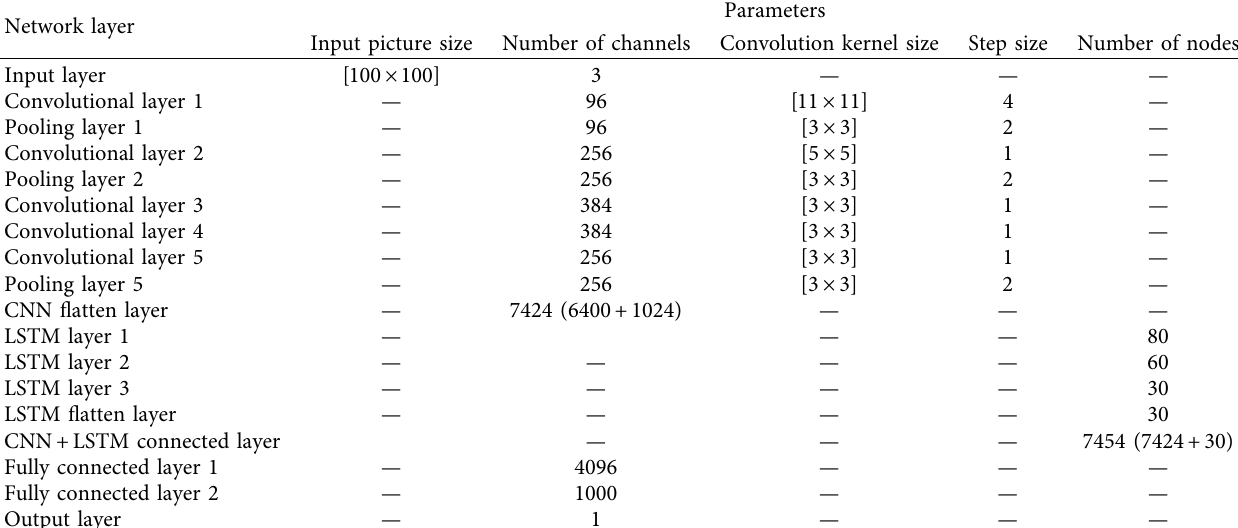
Table 4: Parameters of hybrid deep learning